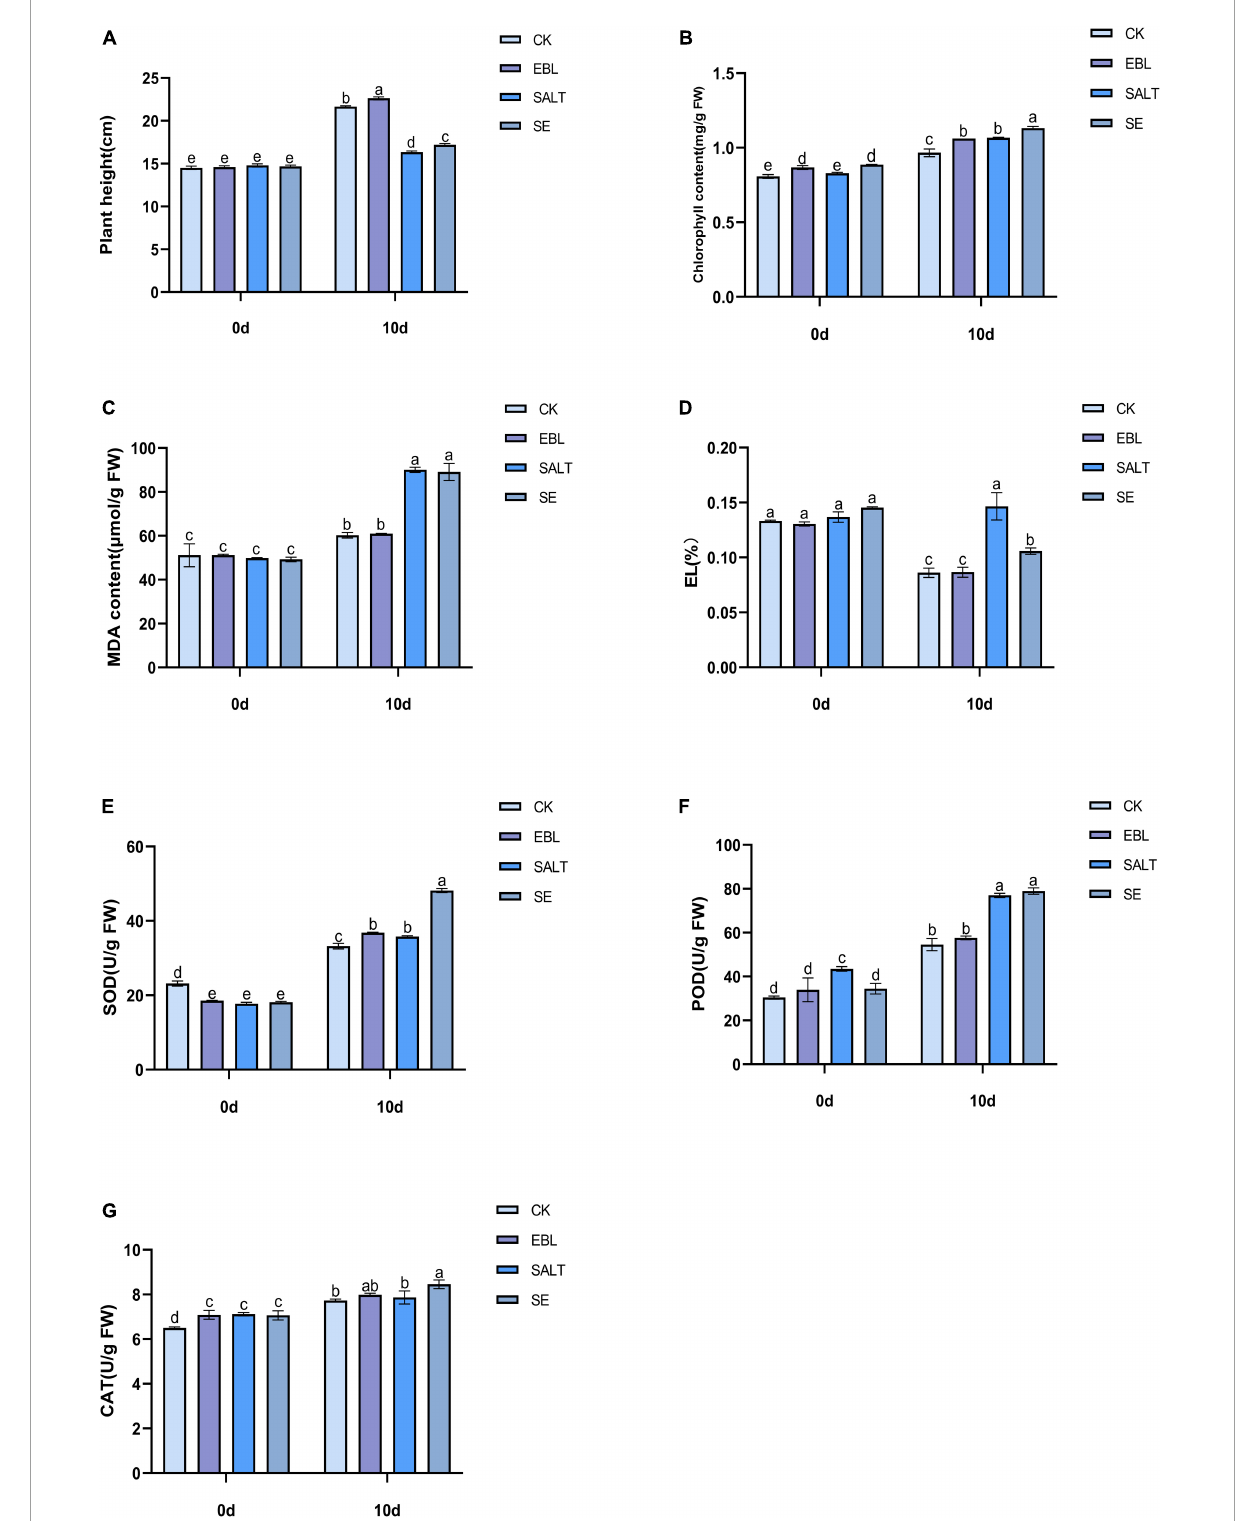
FIGURE1 Effects of exogenous 24-epibrassinolide on growth and physiological characteristics of tall fescue under salt stress. (A) Plant height of tall fescue; (B) Chlorophyll content of tall fescue; (C) MDA content; (D) Electrolyte Leakage; (E) SOD activity; (F) POD activity; (G) CAT activity. Bars with different letters indicate significant difference at P ≤ 0.05 (Duncan